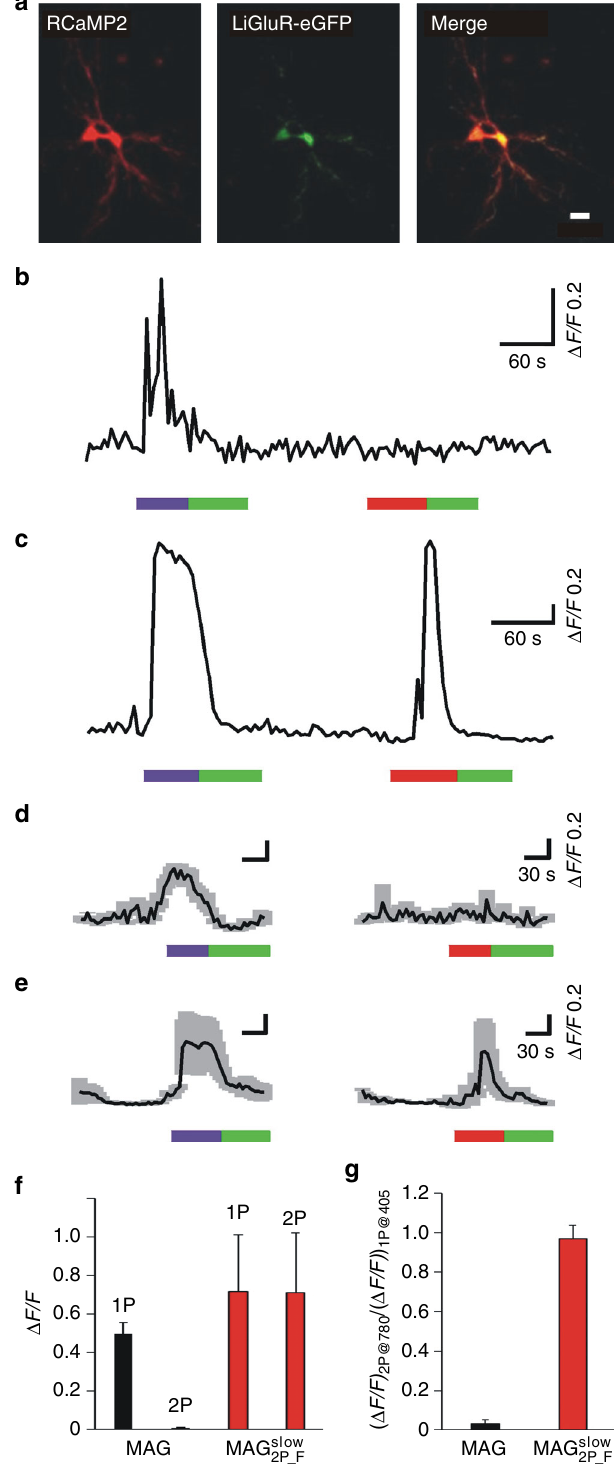
Figs. 7c, e, Supplementary Movies 6 – 7), whereas control-treated animals (vehicle) only showed a partial fl uorescence reduction due to bleaching of mCherry and GCaMP6s ( n = 5 neurons from four different individuals, Fig. 7d). No signs of toxicity were observed after compound injection, during recovery and imaging. Thus, the rationally designed 2P excitation properties of MAG slow can also be used in vivo to photomanipulate neuronal 2P (cid:1) F